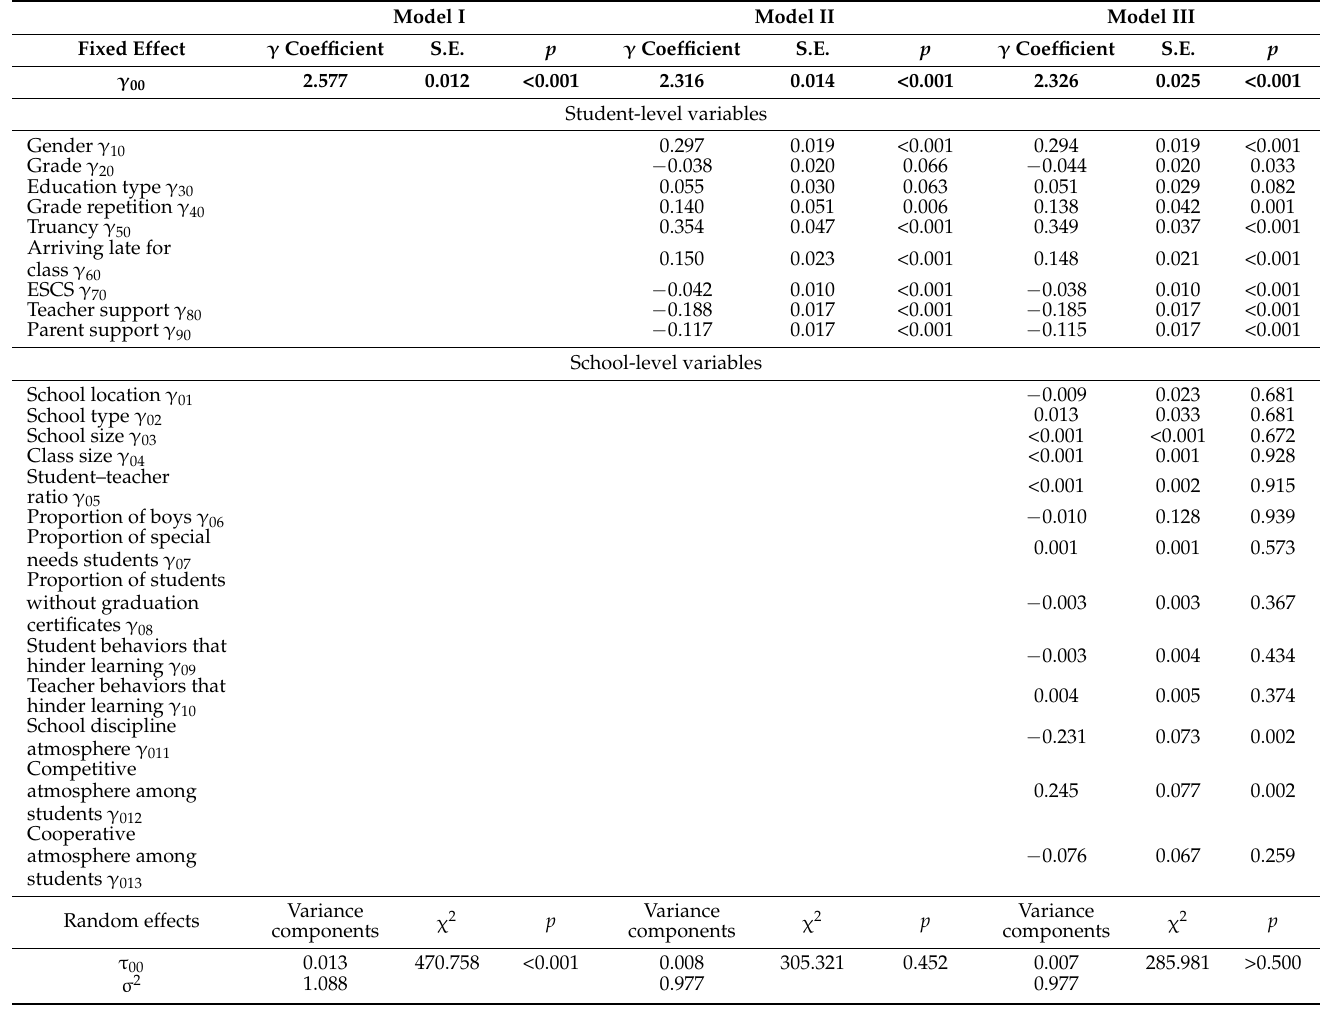
Table A3. Multilevel analysis results of the influencing factors of students suffering from physical